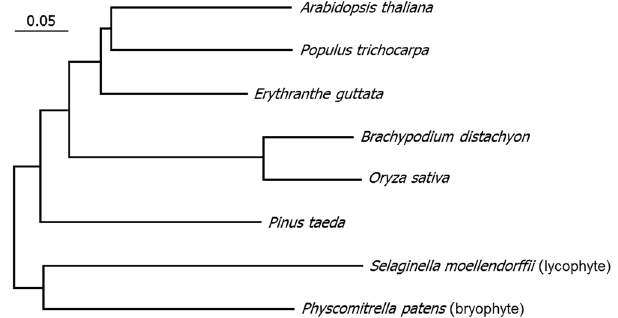
Figure 4. Conservation of heme oxygenase 1 (HO1) enzymes in land plants. HO enzymes mediate the oxidative cleavage of the heme ring to produce biliverdin IX α , the committed step towards the biosynthesis of the phytochrome chromophores, such as PQB. Public database searches identified HO1 enzyme genes from a wide array of plant species, including the earliest land plants (bryophyte and lycophyte). Amino acid sequences of the HO1 proteins were retrieved from the NCBI database (http://www.ncbi.nlm.nih.gov/protein). A phylogenetic tree was constructed using the MEGA7 software with the neighbor-joining